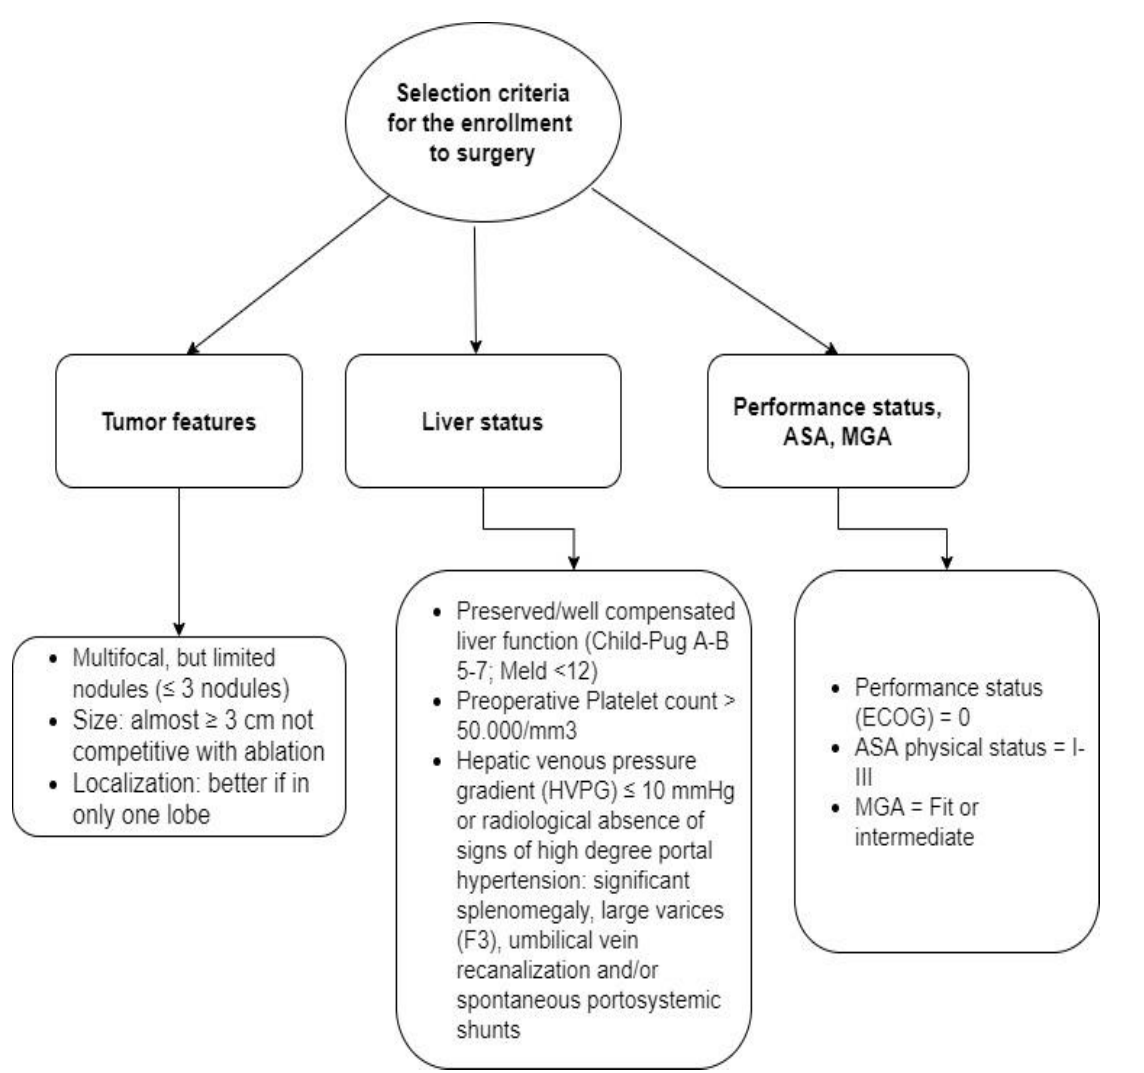
Figure 1. Selection criteria adopted for enrollment to surgery of BCLC-B patients.